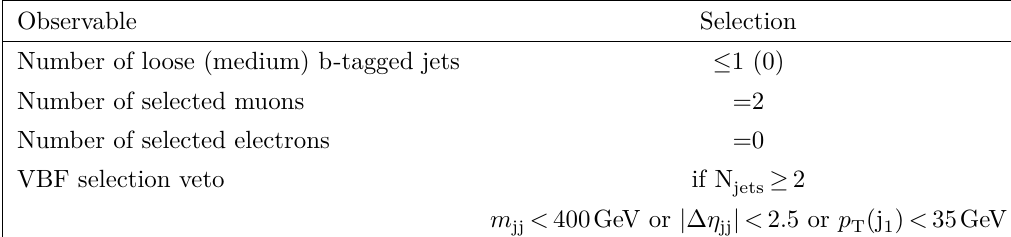
Table 3 . Summary of the kinematic selections used to define the ggH production